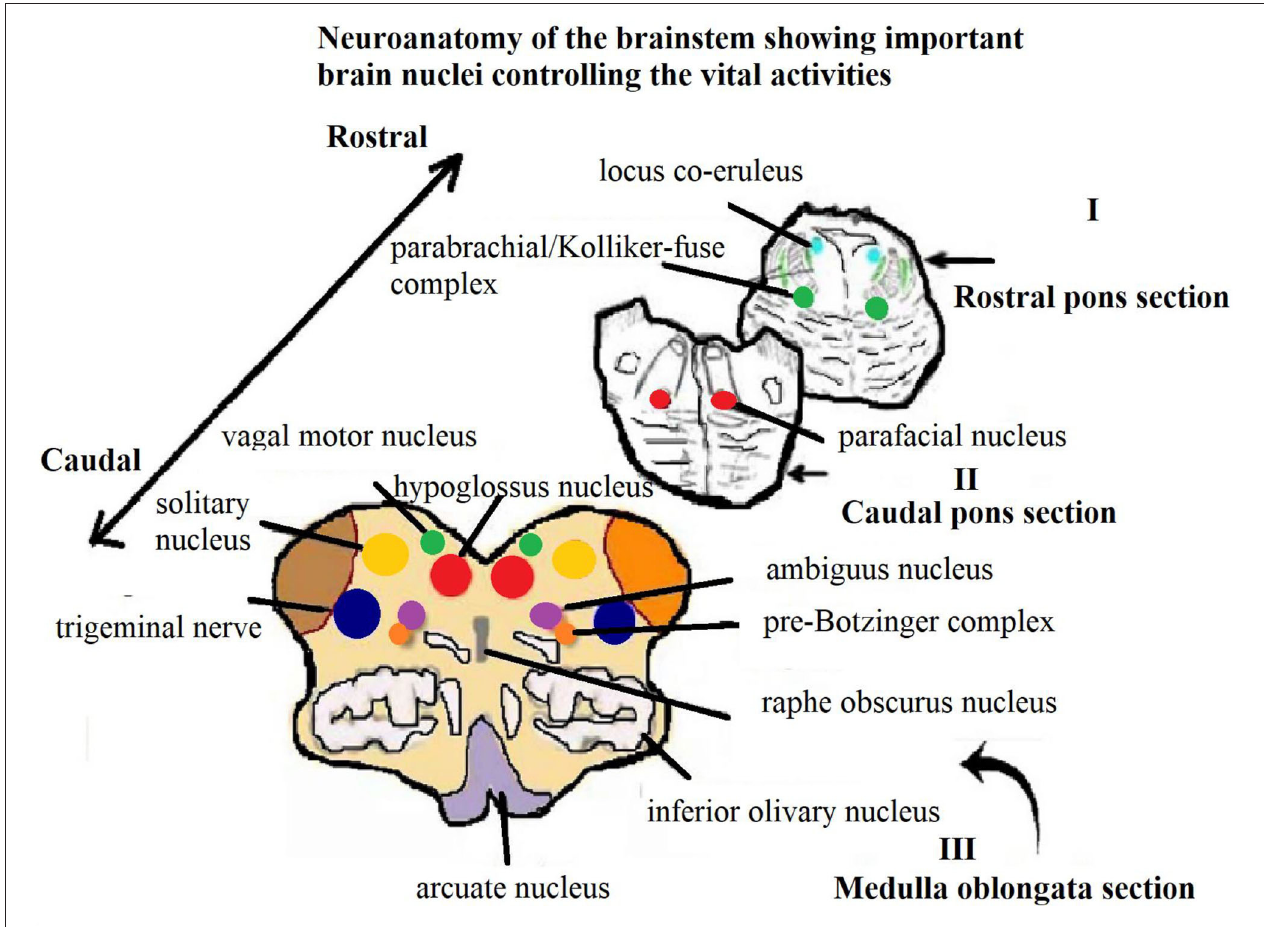
FIGURE 3 | Schematic section of the main histological sections from the brainstem showing Trigeminal nerve and solitary nucleus, which are the main source of Substance P secretion and stimulation ( 28).